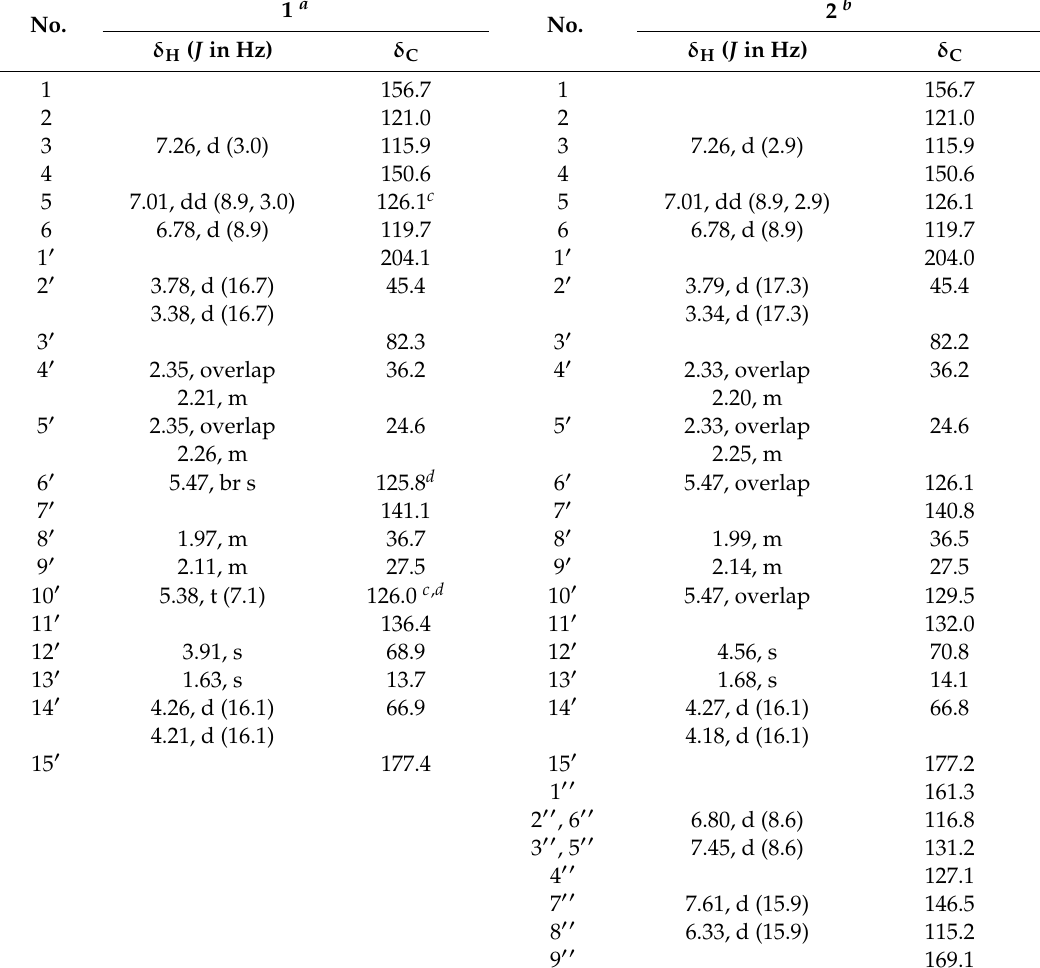
Figure 2. The 1 H − 1 H COSY, Key HMBC and ROESY correlations for 1 – 4 and 7 . Table 1. 1 H and 13 C-NMR data of 1 and 2 .